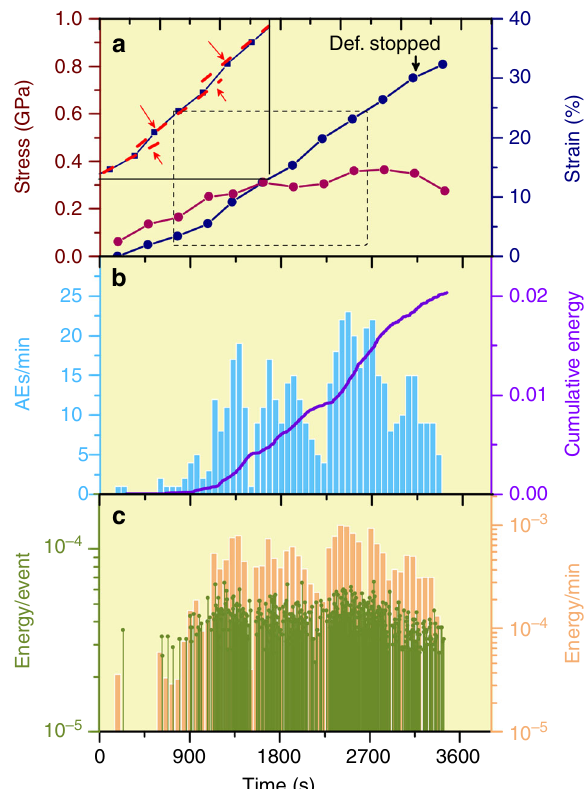
Fig. 3 History of mechanical behavior and AE activity of an EG sample (D1787). a Differential stress and strain. A portion of the strain history (dashed box) is enlarged in the inset, showing two discontinuities. The decrease in stress near the end is due to termination of deformation, not to macroscopic failure. b AE rates and cumulative energy. Note episodic nature of the events, similar to that in Fig. 2. AE rate drops off rapidly after termination of deformation. c Individual event energy and energy release rate. Event energies are of similar magnitudes to those in Fig.